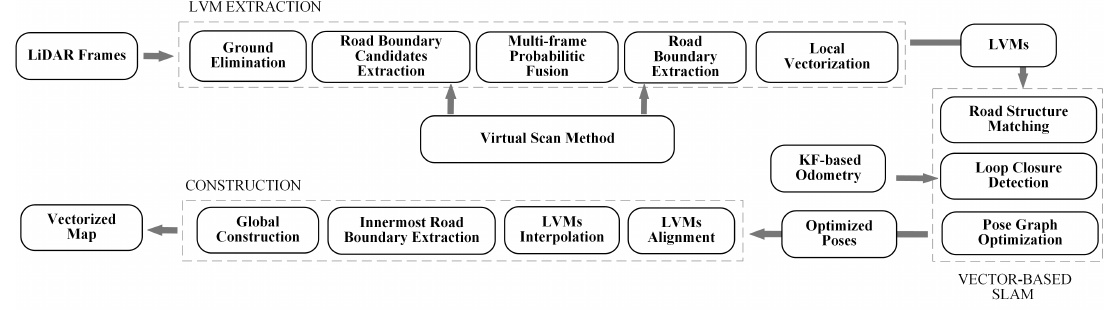
Figure 1. The work flow of the proposed